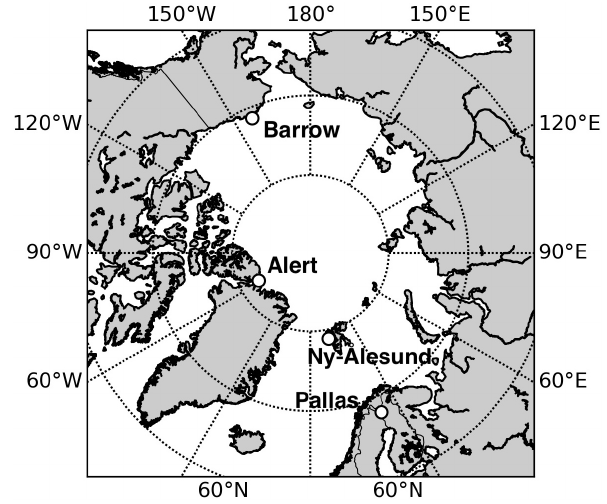
Figure 1. Locations of the Arctic sites where M BC and b abs were measured for this